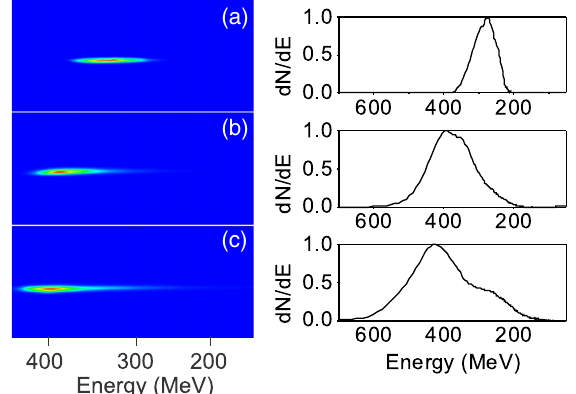
FIG. 9. Images of spectrally dispersed electron beams as a function of laser power and plasma density: (a) P ¼ 40 TW , ¼ 7 : 2 (cid:2) 10 18 cm (cid:3) 3 ; (b) P ¼ 51 TW , n n e (c) (c) P ¼ 58 TW , n e ¼ 5 : 6 (cid:2) 10 18 cm (cid:3) 3 . All images are obtained with a 4 mm jet and a higher-resolution electron spectrometer. The right column contains electron spectra for each case.